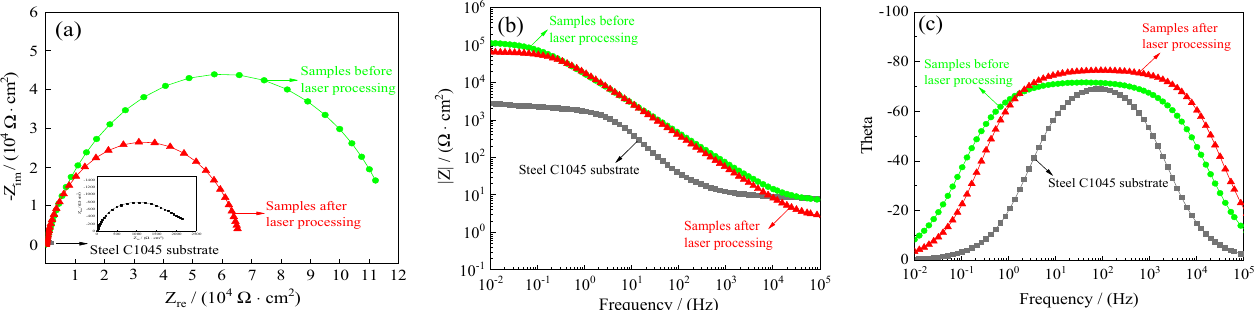
Figure 24. Electrochemical impedance spectra of samples before and after laser processing: ( a ) Nyquist plots (Z re –Z im ), ( b ) Bode plots (F–|Z|), ( c ) Bode plots (F–Theta).